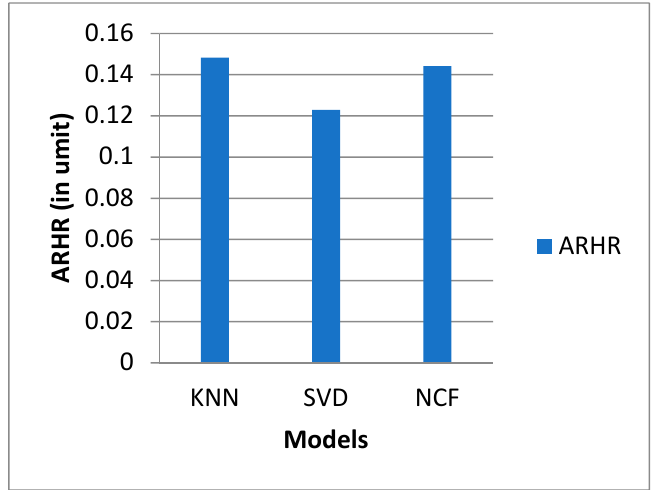
Figure 15. Performance results of different models in terms of ARHR in 80:20 training–testing scenario.